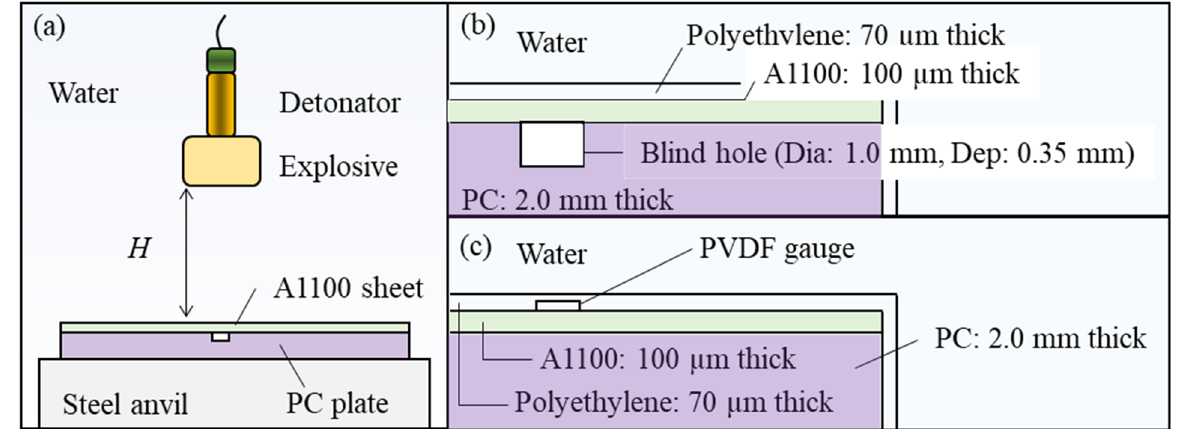
Figure 2. Schematic illustration of the shock-imprinting and pressure measurement experiments using a PC mold. ( a ) The layout of an explosive and sample in water. ( b ) Details of the placement of the PC mold and Al workpiece. ( c ) Details of the PVDF gauge placement.